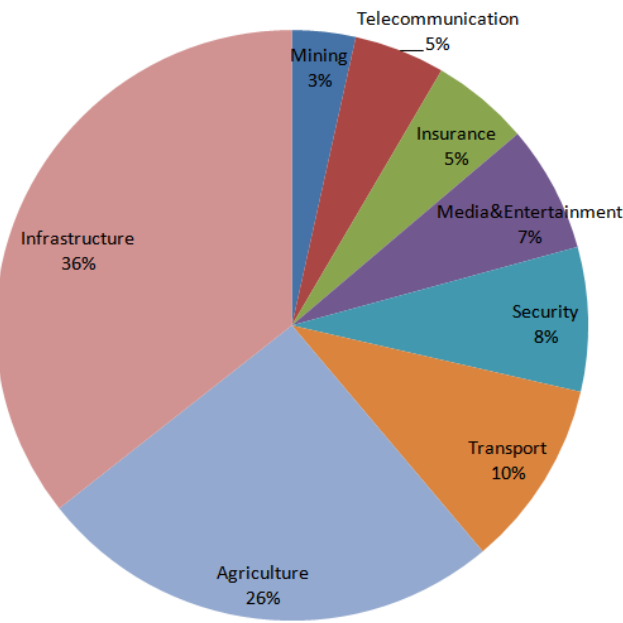
Figure 1. Market prospects of using UAVs. Source: Generated by the authors.